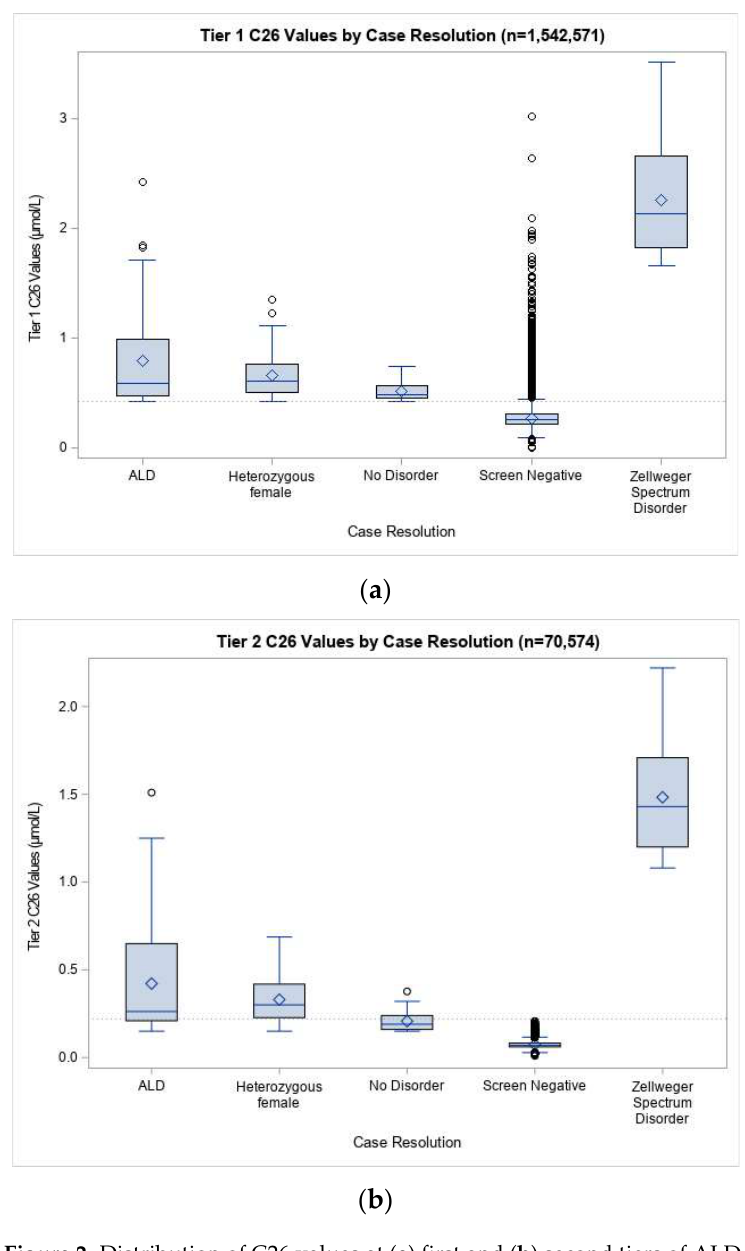
Figure 2. Distribution of C26 values at ( a ) first and ( b ) second tiers of ALD screening for specimens